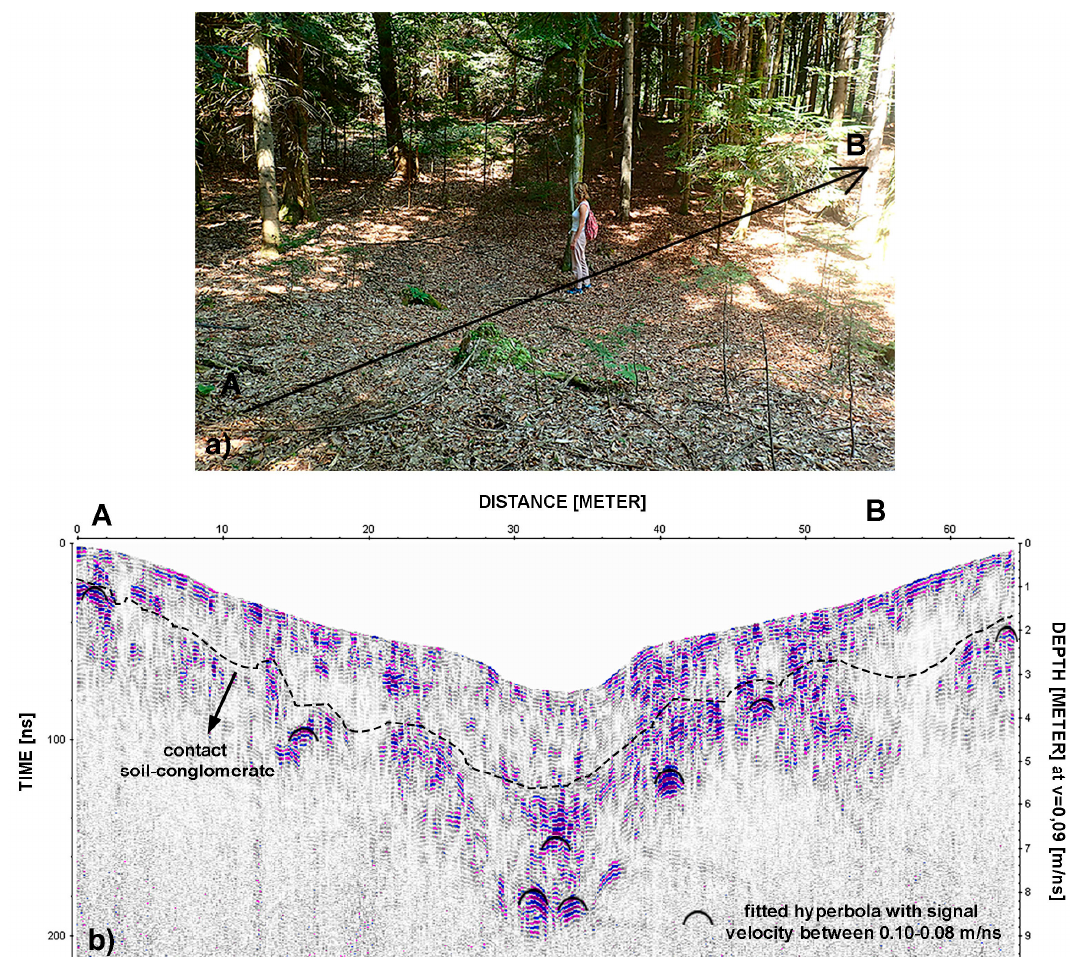
Figure 7. ( a ) The direction of Profile 4 acquired with a 250 MHz antenna over an uncultivated doline on young conglomerate (Podbrezje); ( b ) The soil/bedrock boundary is estimated by the appearance of hyperbolic diffractions caused by cavities and fractures within carbonate conglomerate. Vertical exaggeration 1:3.